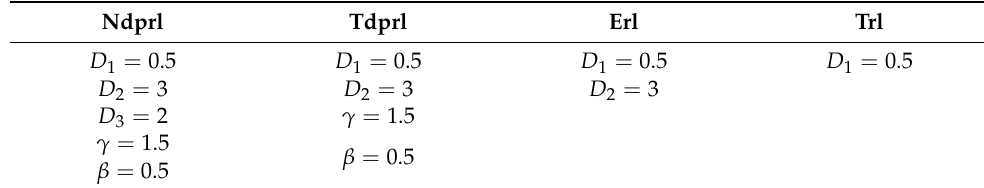
Table 1. Parameters of reaching laws.